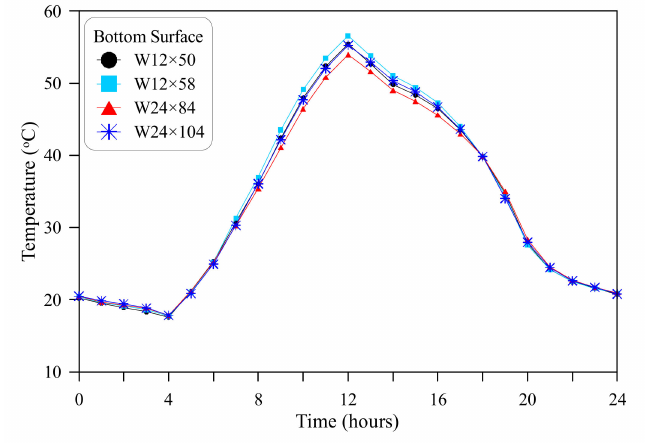
Figure 8. Temperature-time relations for the bottom surface of the steel sections.